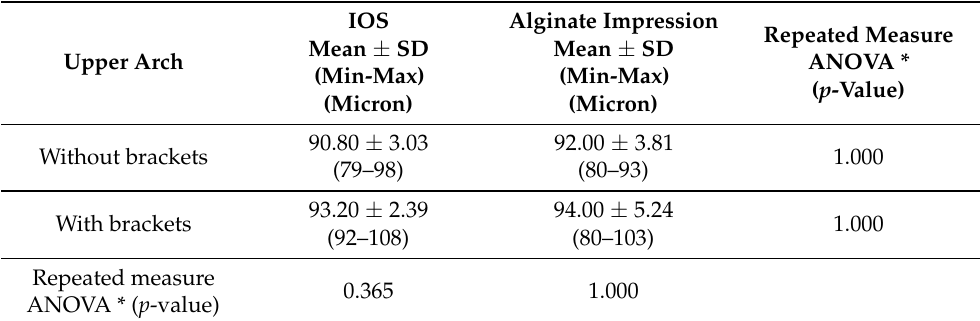
Table 3. Average surface deviation (mean difference and standard deviation) in measurements by IOS, alginate, and control in the upper